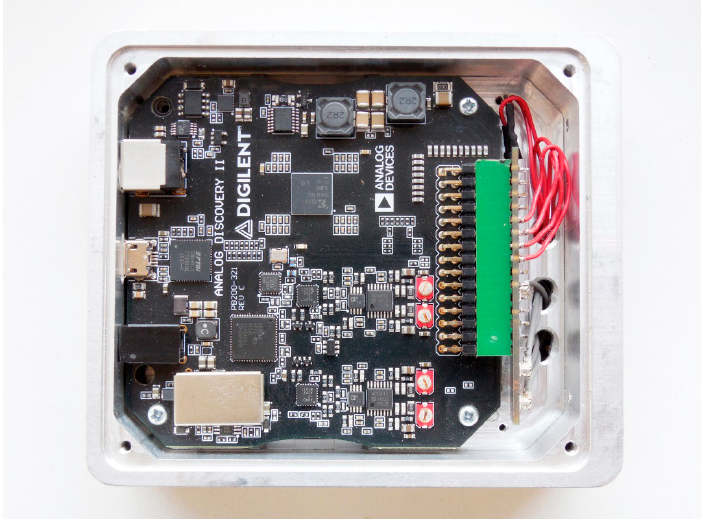
Figure A3. A photograph of the signal processing module with Analog Discovery 2 (bottom cover of the analyzer is removed).